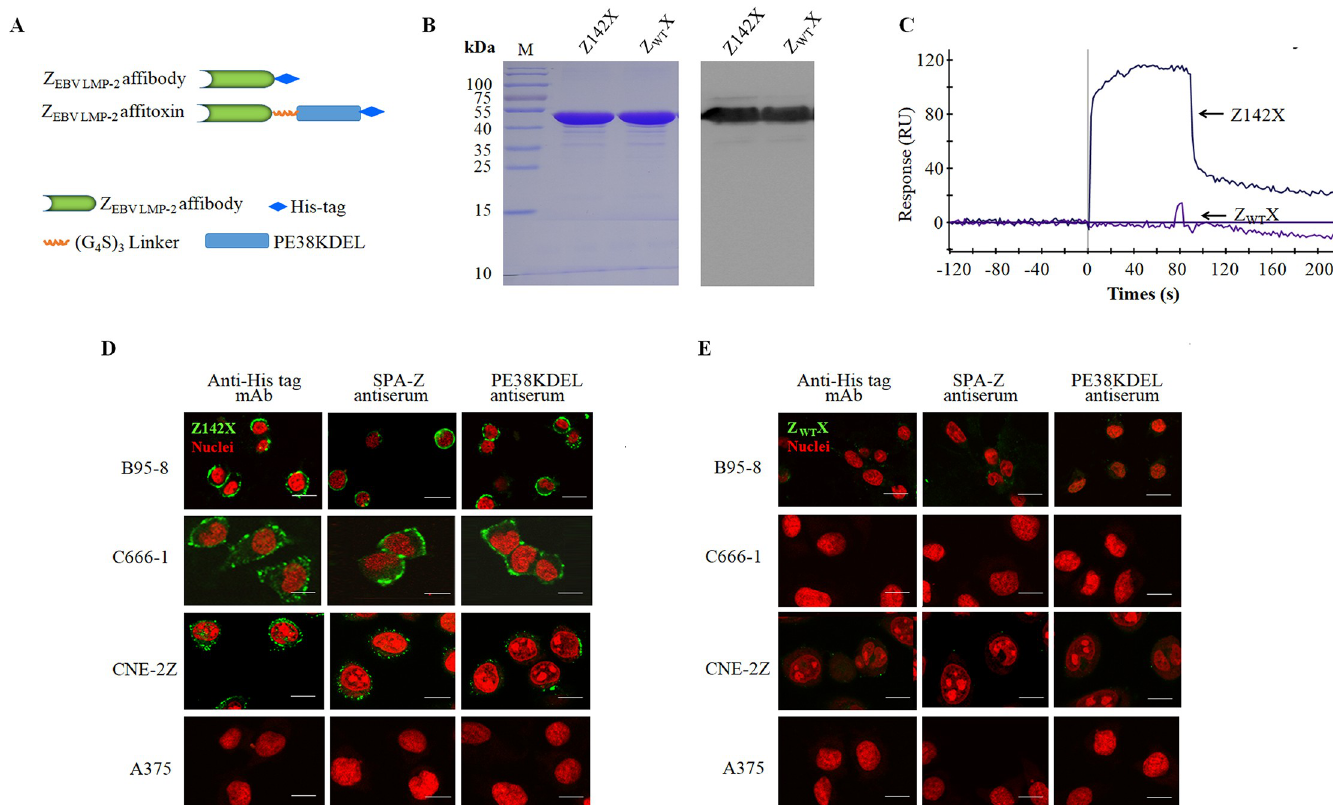
Fig 4. Engineered Z142X affitoxin binds to native EBV LMP-2 with high specificity. ( A ) Schematic structures of Z142X affitoxin. ( B ) SDS-PAGE Coomassie blue staining (left panel) and Western blot (right panel) analysis of purified Z142X and Z WT X. In Western blot assay, anti-His mAb was served as primary antibody. ( C ) Biosensor assays. Representative binding sensor grams show the interaction of affitoxin molecules (5.56 nM) with immobilized recombinant LMP-2 B-epitope fusion protein (1nmol). ( D & E ) Fluorescence staining of EBV + B95-8, C666-1 and CNE-2Z cells with Z142X ( D ) or unselected original affibody scaffold molecule Z WT X ( E ). The Z WT X affitoxin with no binding affinity to LMP-2 served as a control. Mouse anti-His mAb, rabbit SPA-Z polyclonal antiserum and mouse PE38KDEL polyclonal antiserum were used respectively as a primary antibody. FITC-conjugated goat anti-mouse IgG and goat anti-rabbit IgG were used as the secondary antibodies (green). EBV-negative melanoma A375 cells labelled with the same Z142X molecules served as control cells. Cell nuclei were counterstained with PI (red) (600 × ). Scale bar, 20 μ m.